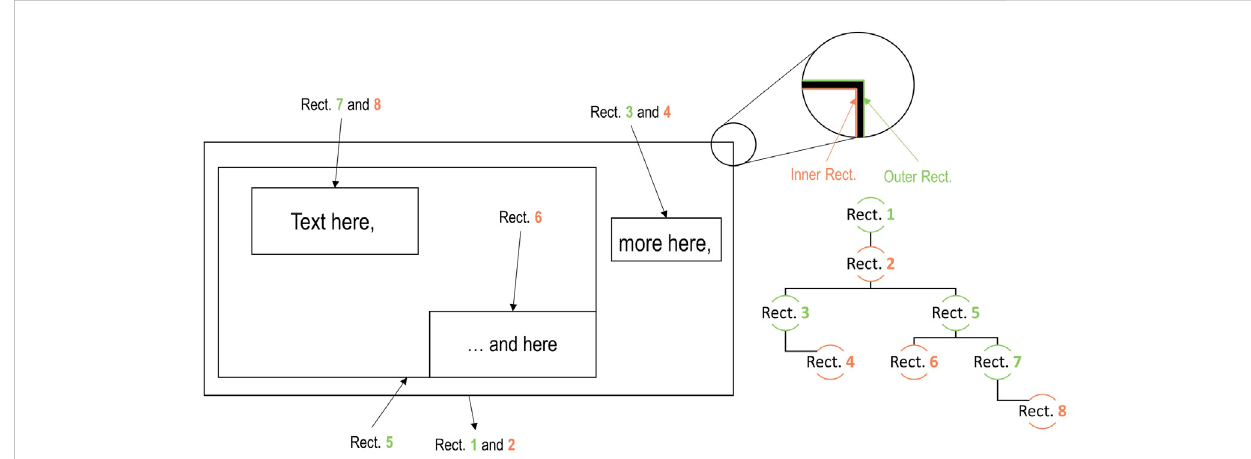
FIGURE 7 Tree Hierarchy for a general image. Inner rectangles are highlighted in orange and outer rectangles in green.